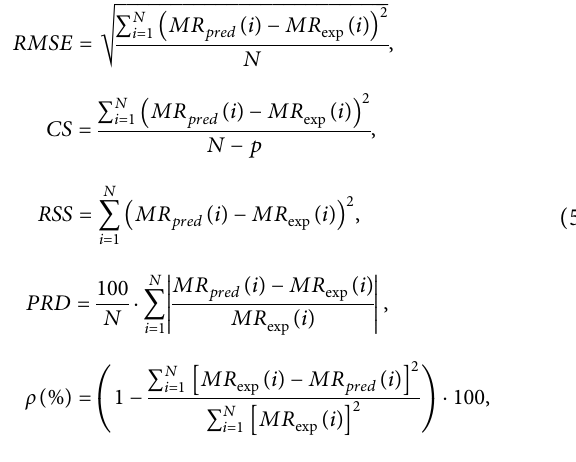
Figure 1: Artificial neural network topology structure. (a) Signal-flow graph of a perceptron, where ( x w m ) are the weights; b is the bias; v is the linear combination of the inputs, weights, and bias ( and y � f (v) is the output. (b) Example of a three-layer multilayer perceptron with two inputs, one output, and three neurons in the hidden